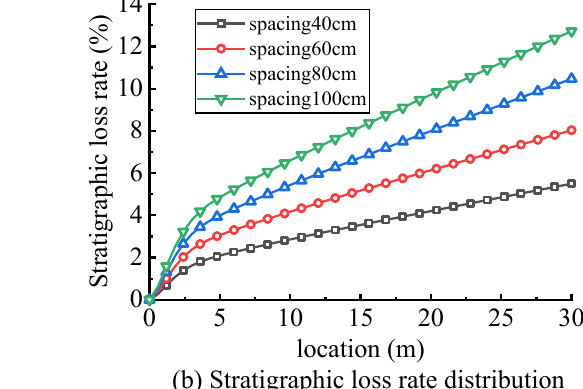
(b) Stratigraphic loss rate distribution